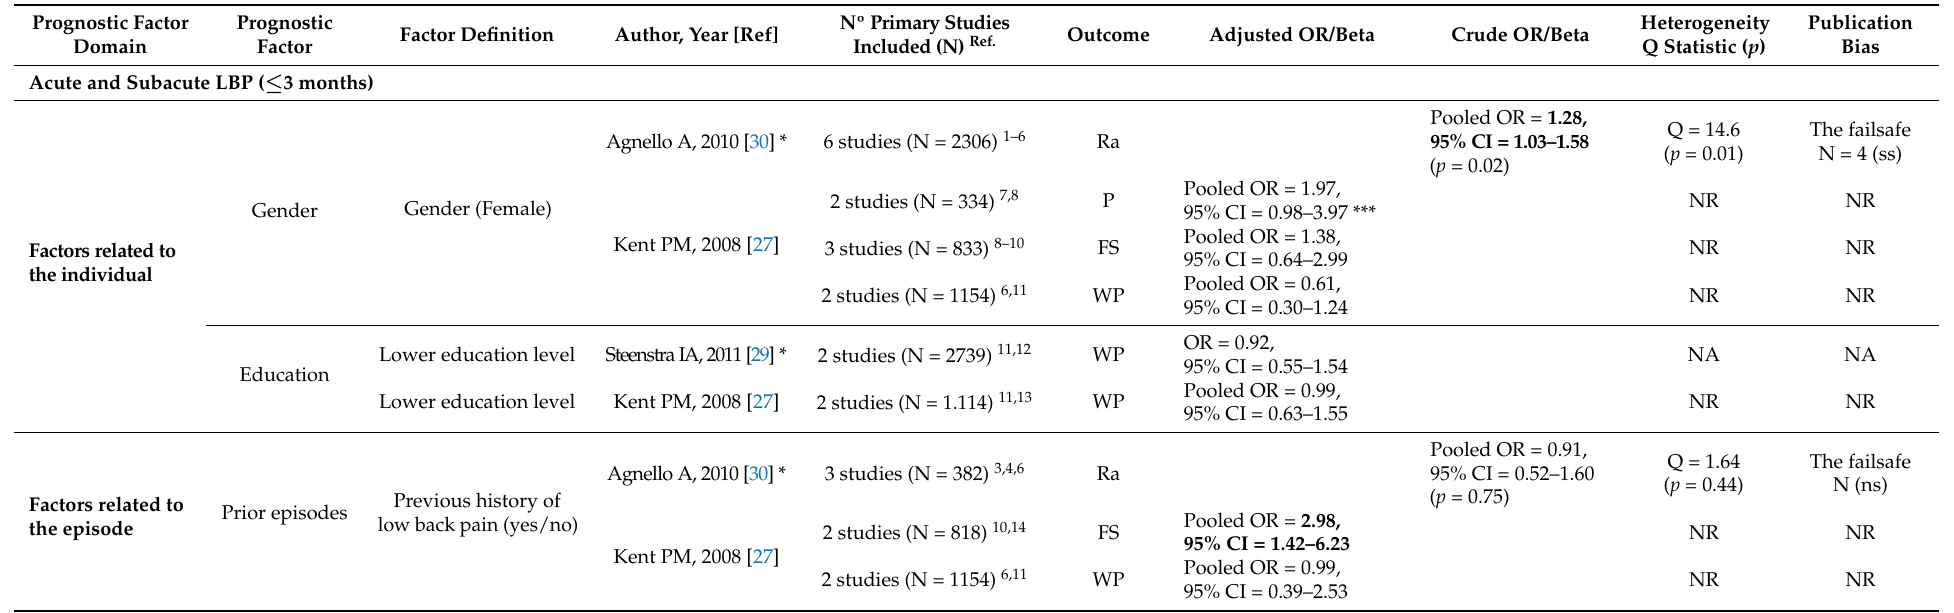
Table 2. Results of prognostic factors for LBP outcomes at long term, reported by two or more systematic reviews using OR/beta